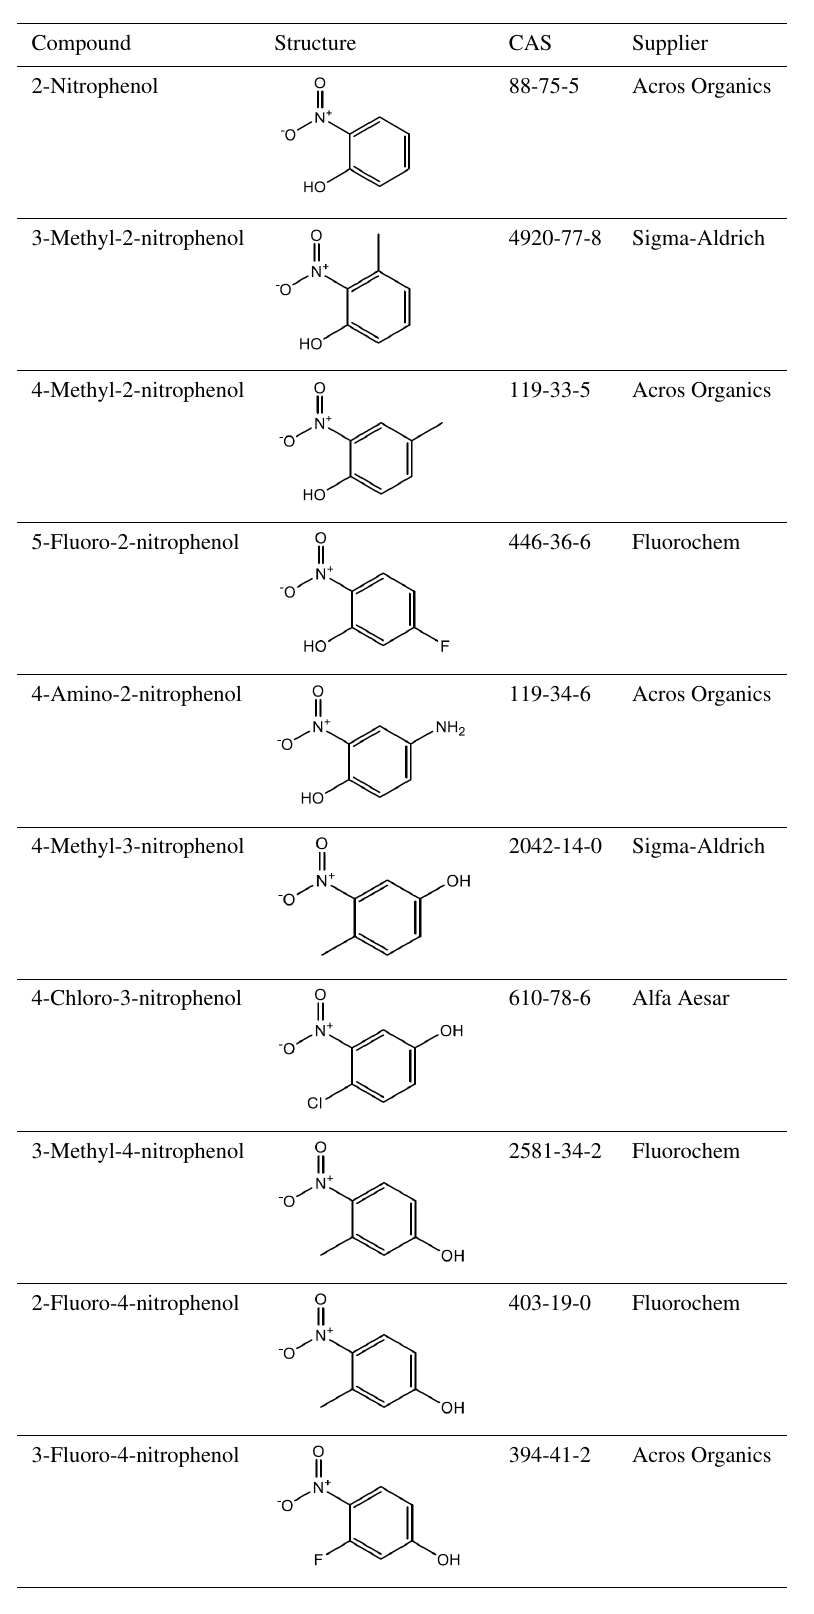
Table 1. Nitrophenols measured with the